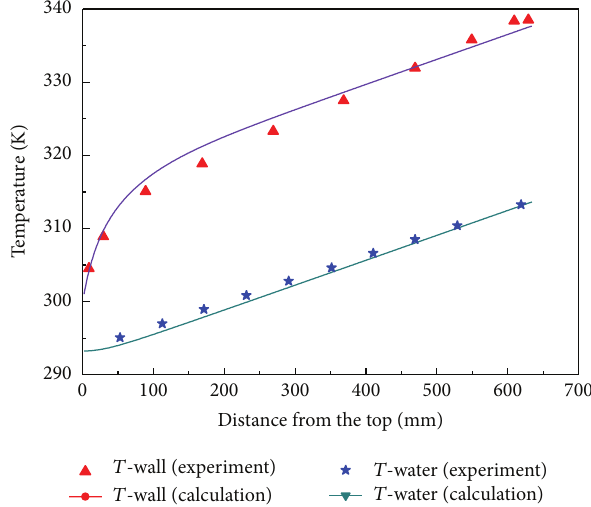
Figure 6: Temperature comparison in the axial direction (experi- ment data are from